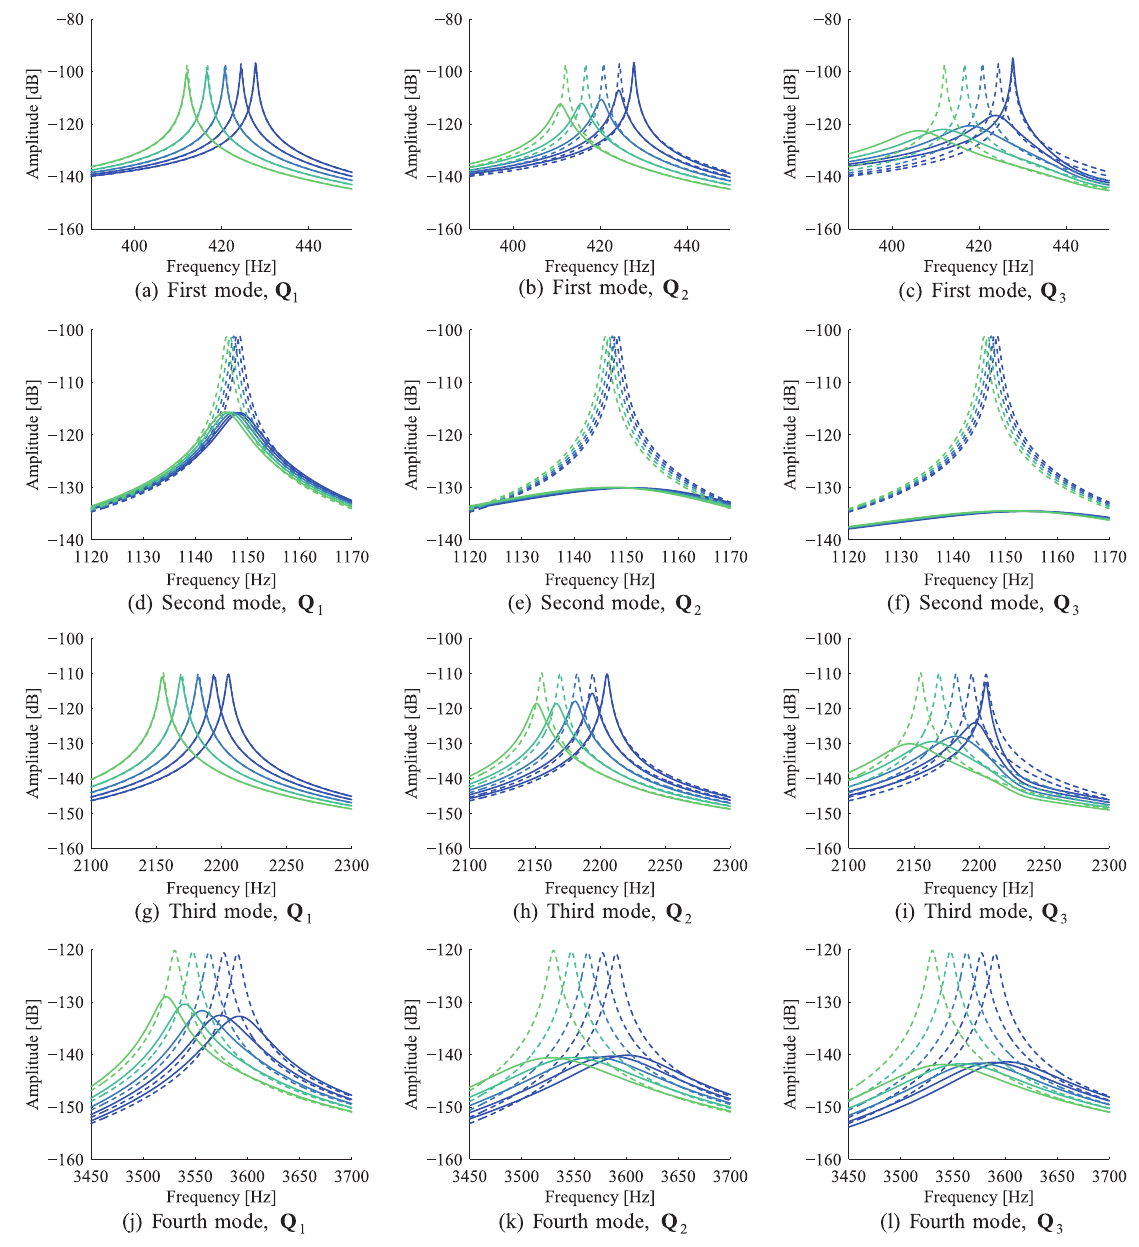
Fig. 5. Uncontrolled ( - - ) and controlled ( — ) FRF of the multi-cracked beam in the first case for the first fourth mode ( (cid:2) : μ = 0 , (cid:2) : μ = 1 / 16 , (cid:2) : μ = 1 / 8 , (cid:2) : μ = 3 / 16 , (cid:2) : μ = 1 / 4 ) for three ponderations Q 1 , Q 2 and Q 3 . variation induced by the crack depth variation from μ = 1 / 16 to μ = 1 / 4 , usually measured to detect cracks, is about − 0.8 to − 3.8% for the first mode, 0 to − 0.2% for the second mode, − 0.5 to − 2.3% for the third mode and − 0.4 to − 1.7% for the fourth mode. Howeover, due to the small depth of each cracks, detection of the presence of cracks based on the evolution of natural frequencies appears to be not efficient. Identified frequency and damping for three weighting matrices are presented in Figs 6(a)–(d) for the first fourth modes. The modal structural damping variation in less than 1% for the four modes. The damping variation for the controlled beam using the Q 1 weighting matrix is about 18.6 to 33.8% for the first mode and 7.6 to 12.6% for the third mode, 72 to 85% for the first